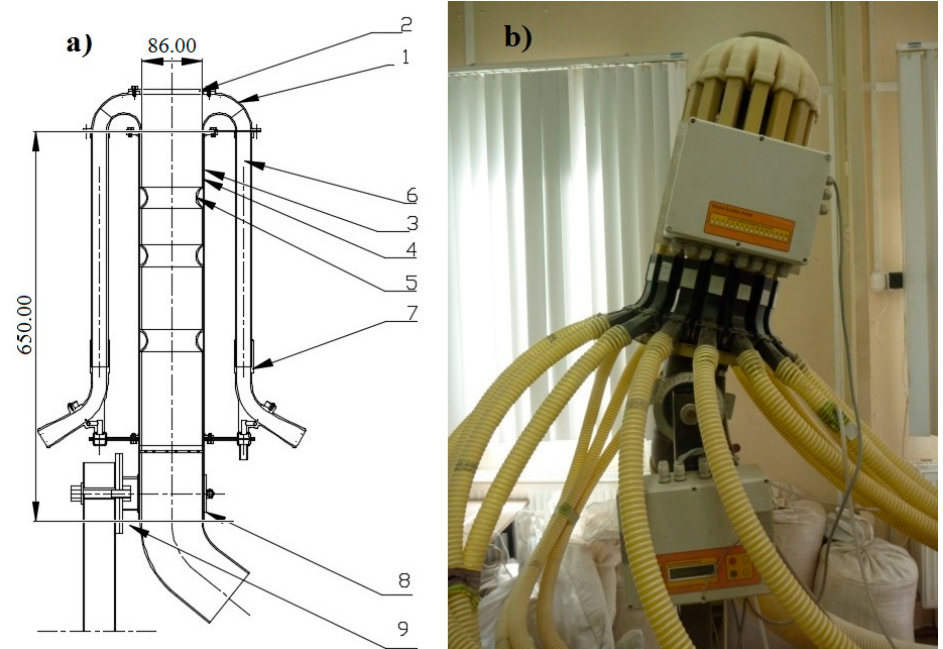
Figure 1. The distribution head and the diffuser of the pneumatic seed drill: ( a ) diagram with basic dimensions: 1—stream distributor, 2—cover, 3—diffuser with diffusion rings, 4—spacer sleeve, 5—